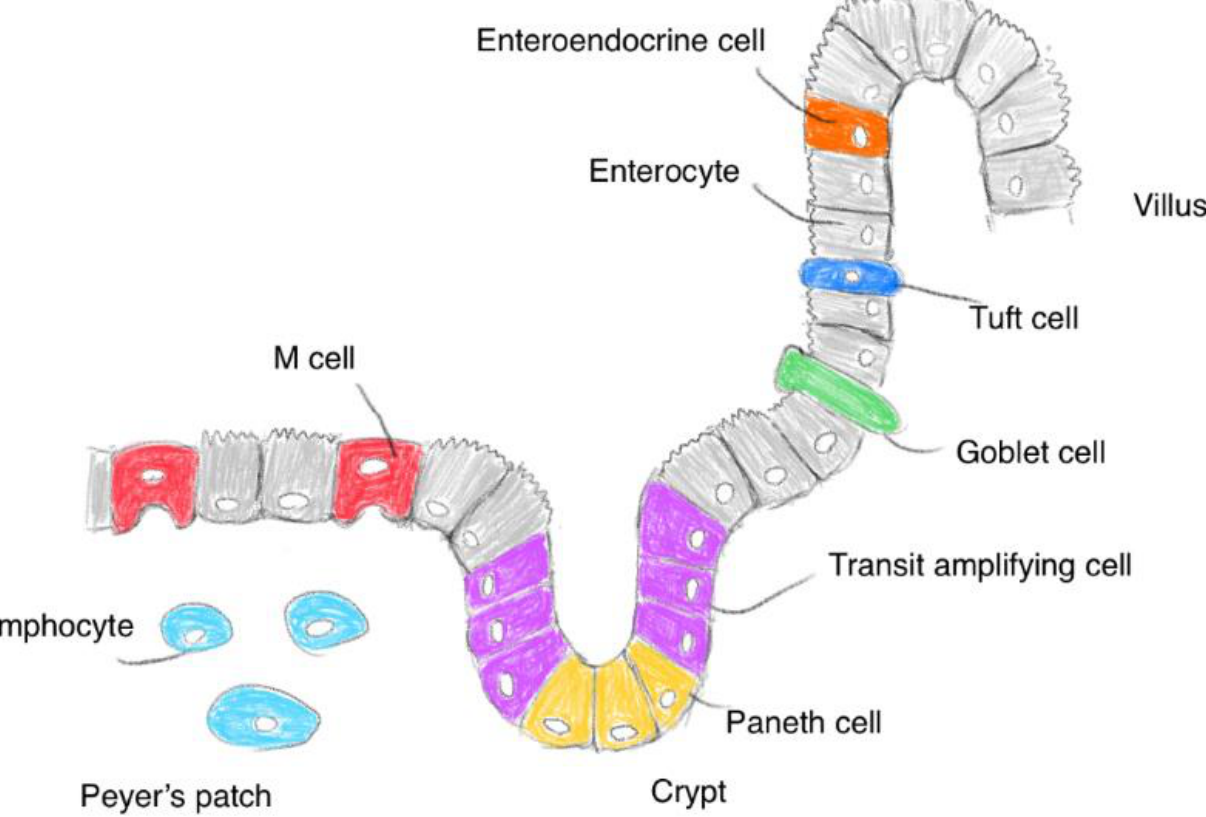
Figure 2. Pattern diagram of the small intestinal surface.